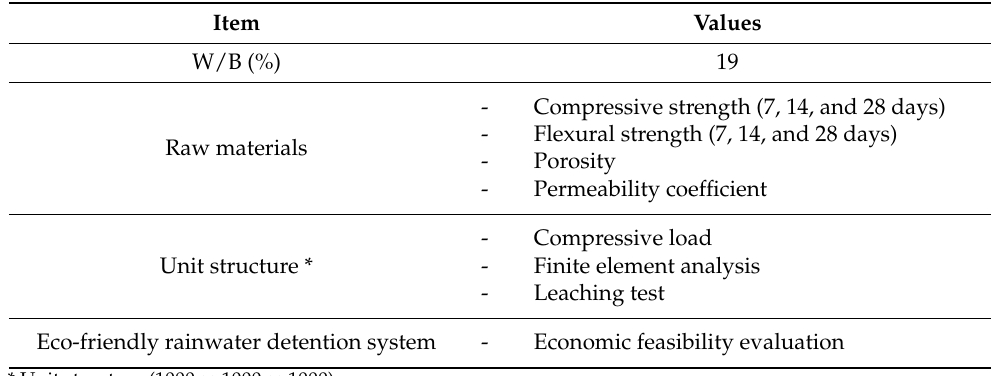
Table 2. Experimental plan.